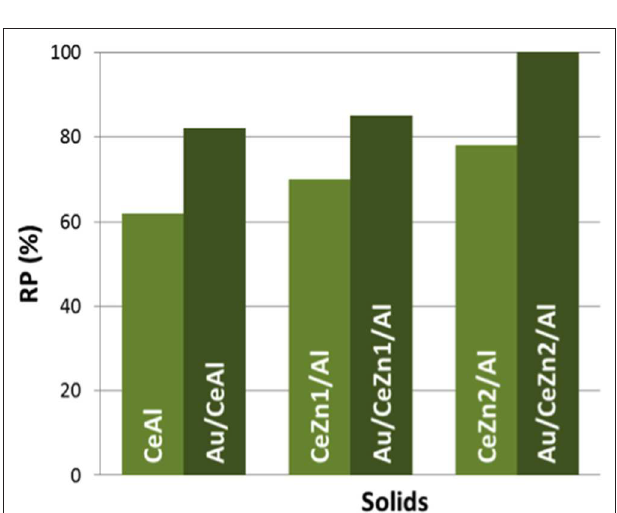
FIGURE 3 | TPR-H 2 profiles of the supports (full lines) and their corresponding gold catalysts (dashed lines).